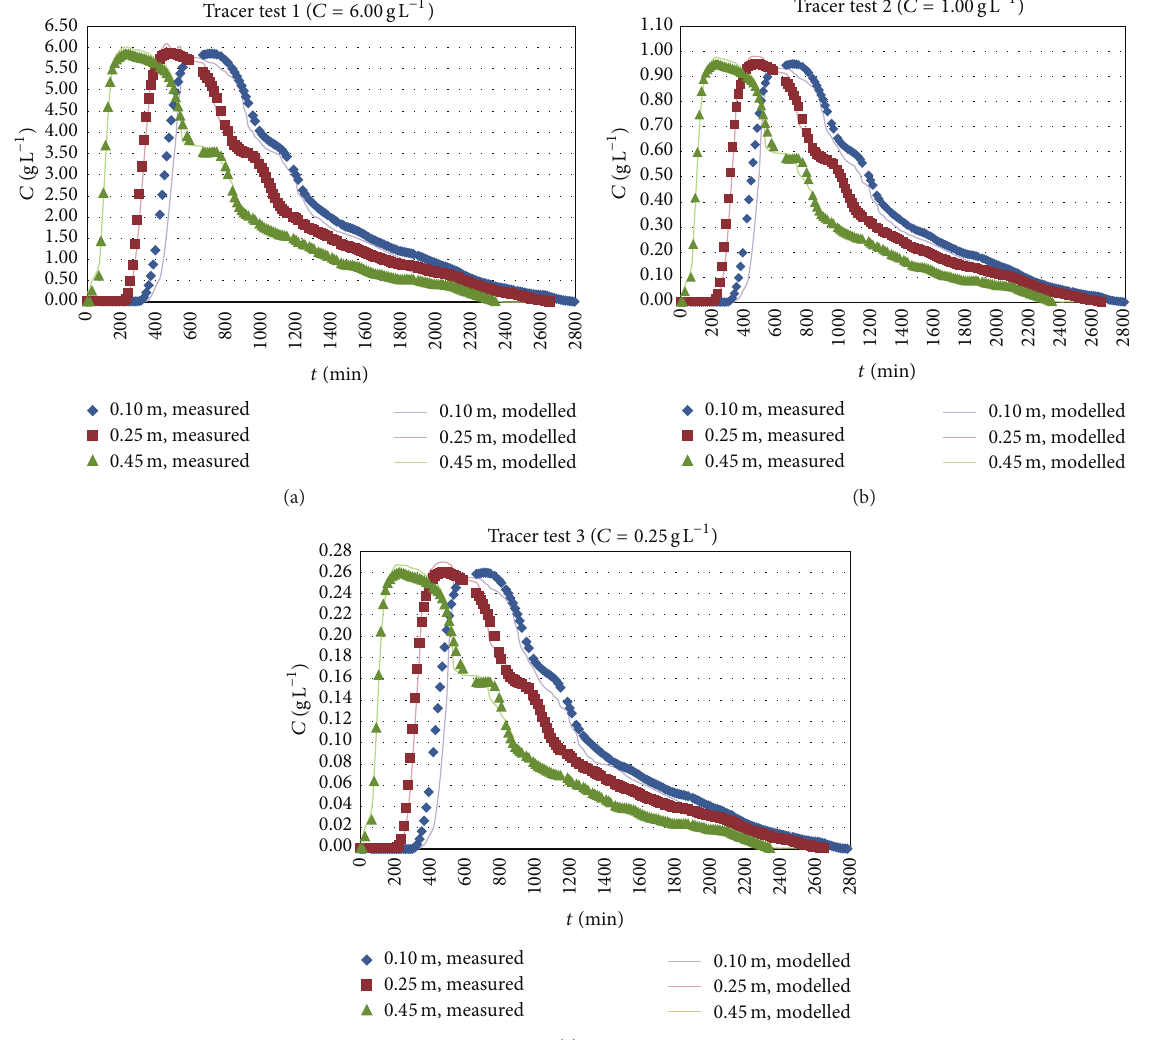
Figure 9: Comparison between breakthrough curves obtained from self-potential signals (dots) and those calculated by inversion (lines) for the tracer test with a salt concentration of (a) 6.00 g L −1 , (b) 1.00 g L −1 , and (c) 0.25 g L −1